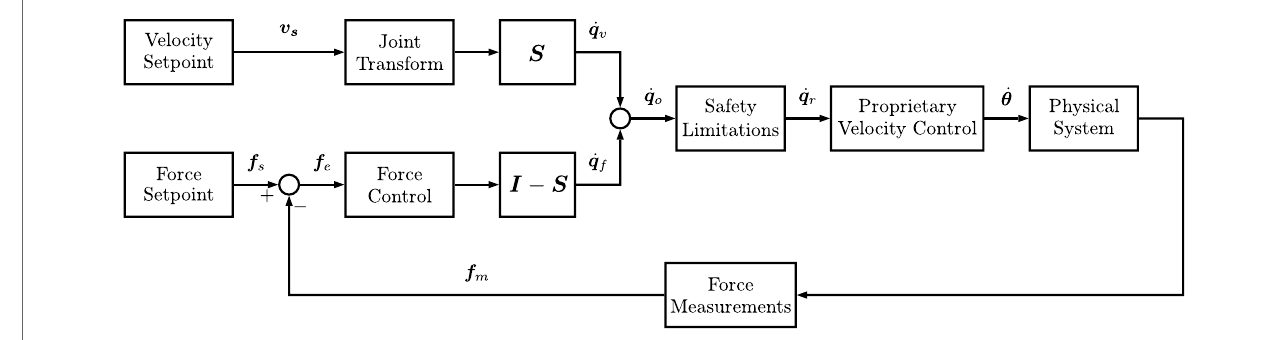
FigUre 6 | hybrid velocity and force